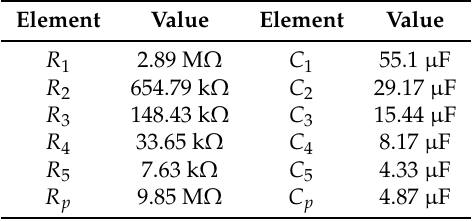
Table 3. Values of the passive elements for approximating a capacitor of order λ = 0.7 and pseudo- capacitance C λ = 22 µ F/s 0.3